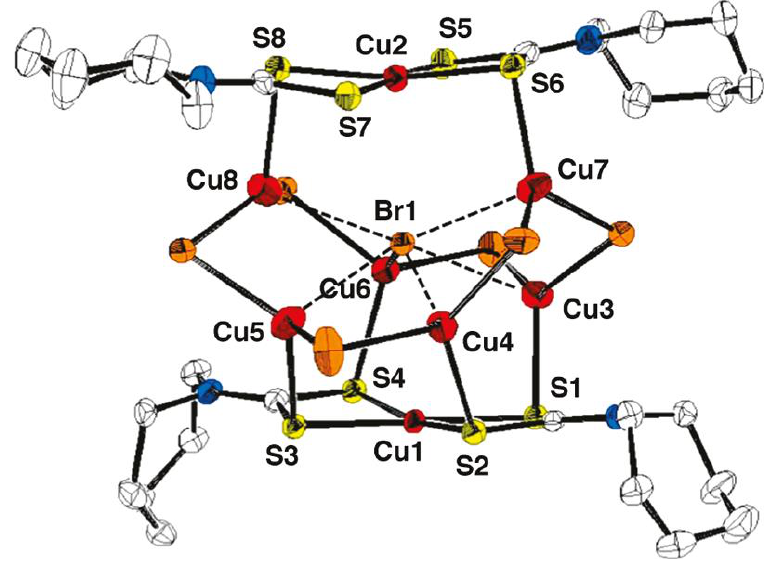
Figure 20. The molecular structure of [Cu 8 Br 7 (S 2 CNC 6 H 12 ) 4 ]. Reproduced with permission from [151]. Copyright 2011 American Chemical Society.